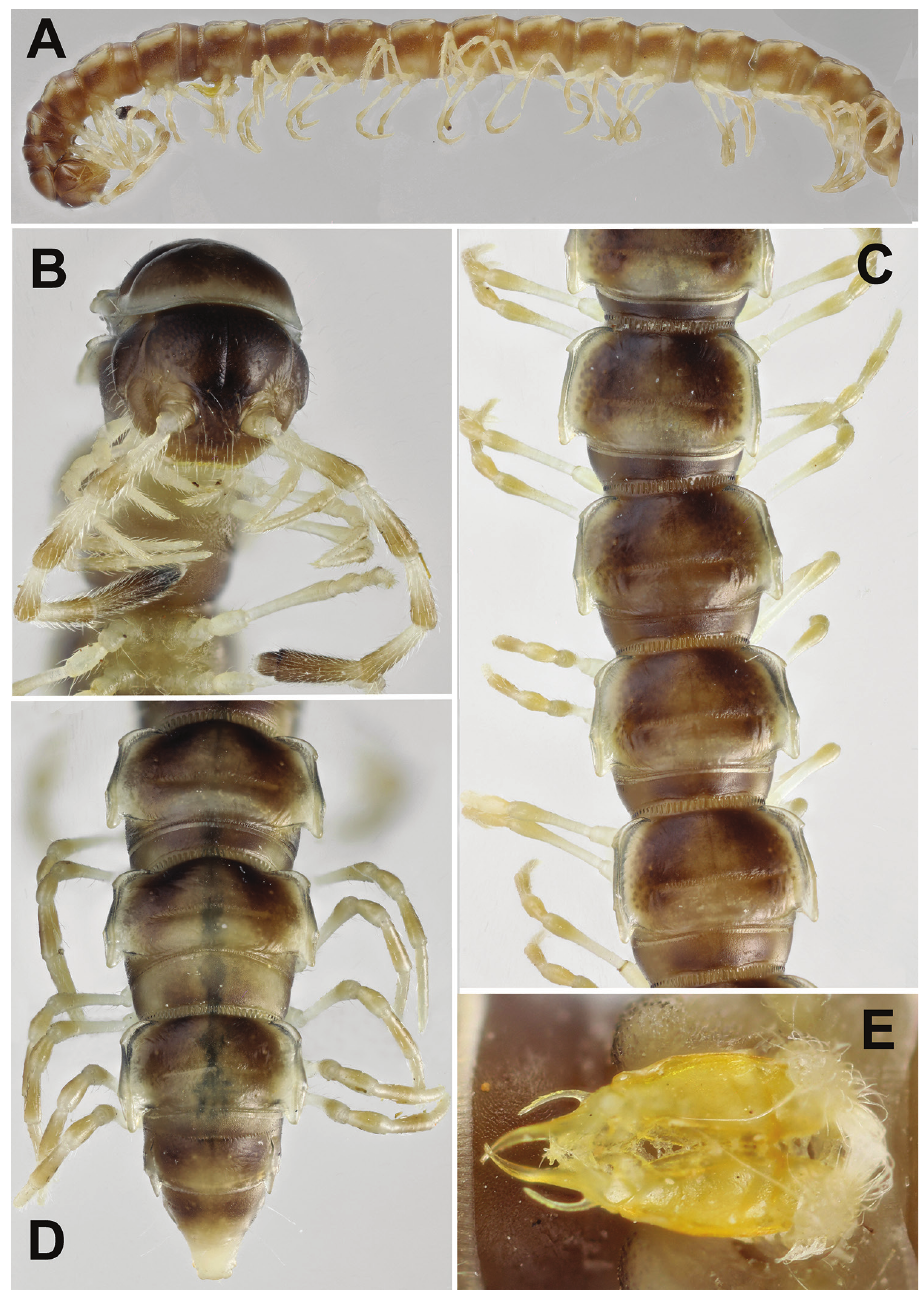
Figure 8. Annamina irinae sp. n., ♂ paratype (ZMUM). A habitus, lateral view B anterior part of body, anteroventral view C midbody segments, dorsal view D caudal part of body, dorsal view E gonopods, ventral view. Pictures taken not to